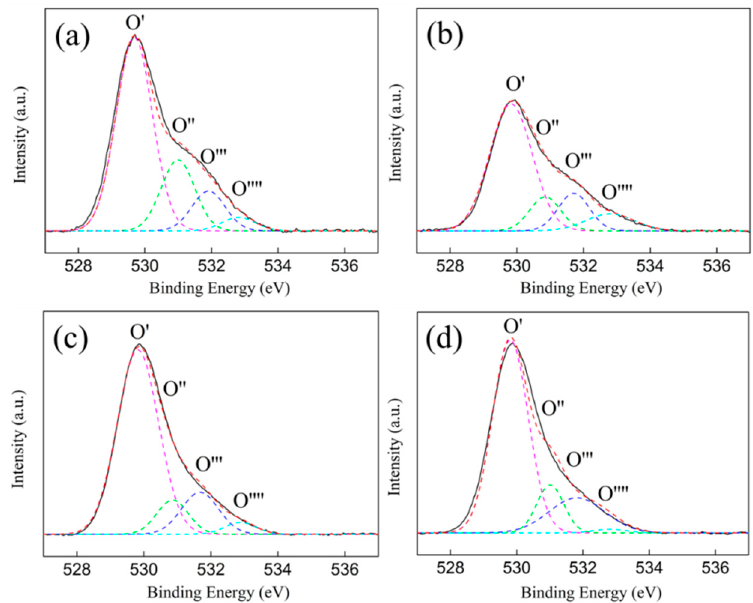
Figure 6. O 1s XPS spectra of the ZrO 2 supports and Ni/ZrO 2 catalysts: ( a ) ZrO 2 (P), ( b ) ZrO 2 (H), ( c ) Ni/ZrO 2 (P), and ( d ) Ni/ZrO 2 (H).